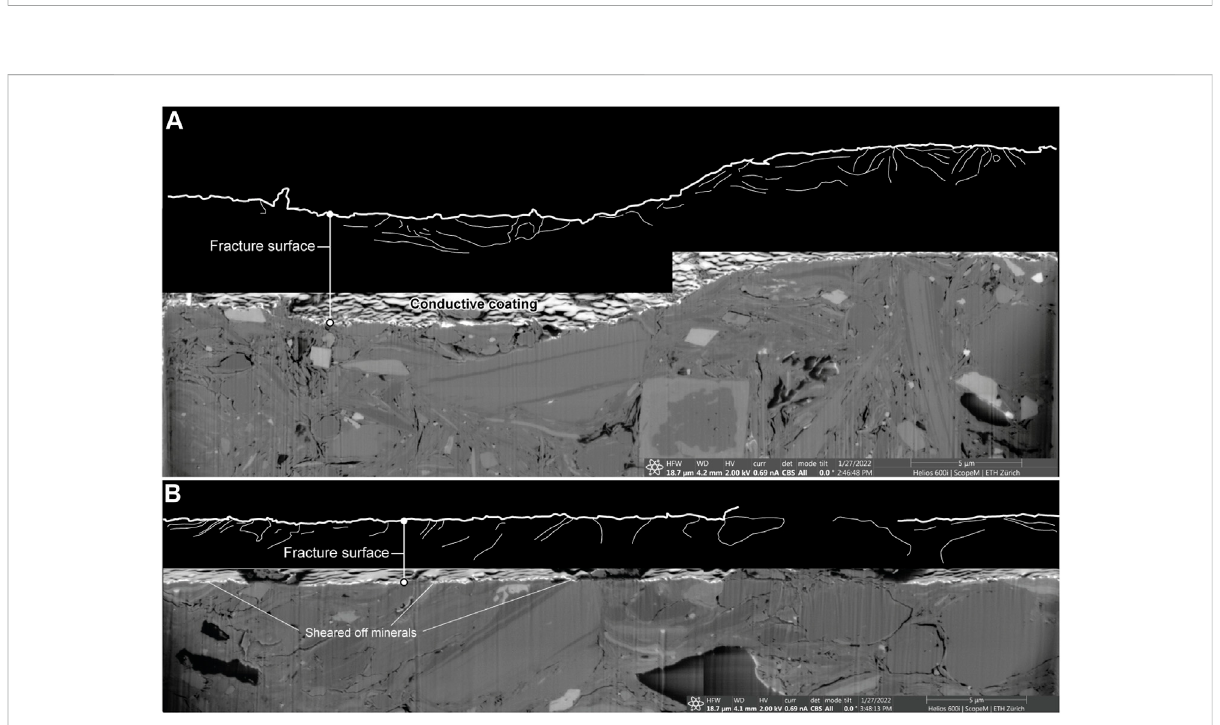
FIGURE 2 Focused Ion Beam investigations on Opalinus Clay samples. (A) Back scatter electron (BSE) image sowing a cross-section perpendicular to the slickenside fracture surface. (B) Same as (A) but for the glassy fracture surface. In the upper black part of the fi gure, one can see the drawn height pro fi le of the shear plane with the traces of the visible grain boundaries in the area of the shear